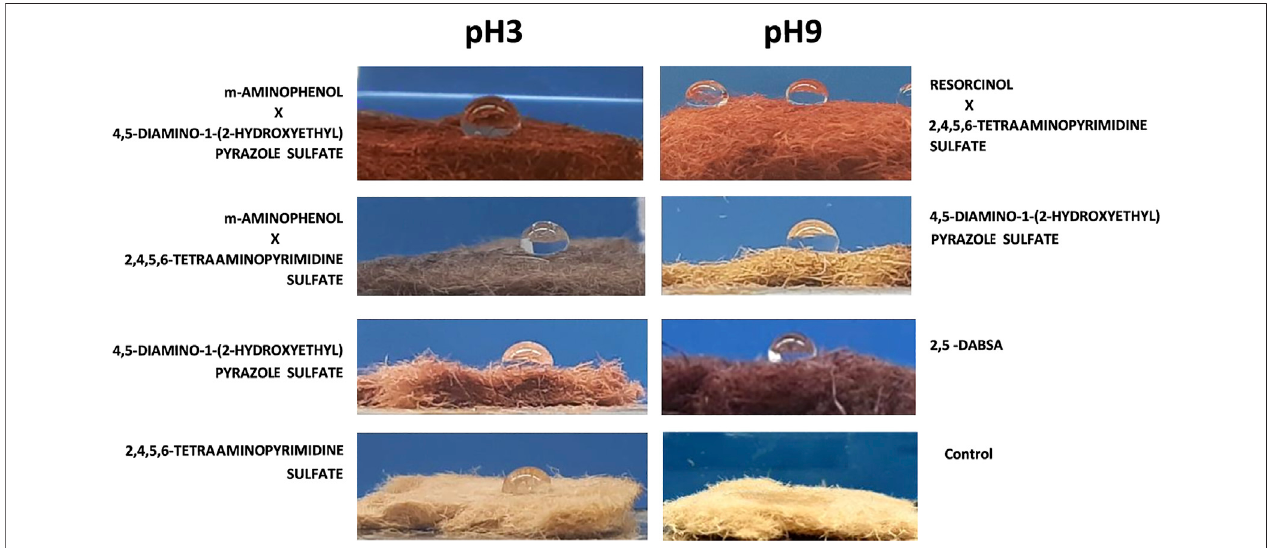
FIGURE5| Waterdropdepositionsofthelessabsorbentwood fi bersdyedwithlaccaseandsingleprecursorsolutionsorheteromolecularmixtures.20 ulofwater solution was dropped on the pressed fi ber surface, and the picture was taken after 2 s from the deposition only for the droplet that was not immediately absorbed. The controlswereincubatedwiththesameenzymaticsolutionsatbothpHinabsenceofprecursors.Theydisplayedthesamebehaviorandoneofthemisreportedinpicture as reference.